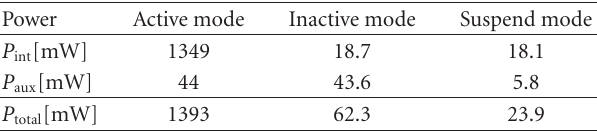
Figure 4: Variation of inactive power consumption with duty cycle. Table 5: Total core power in a Xilinx Spartan-3AN 700 FPGA for active, inactive, and suspend modes. All values are measured at 25 ◦ C.